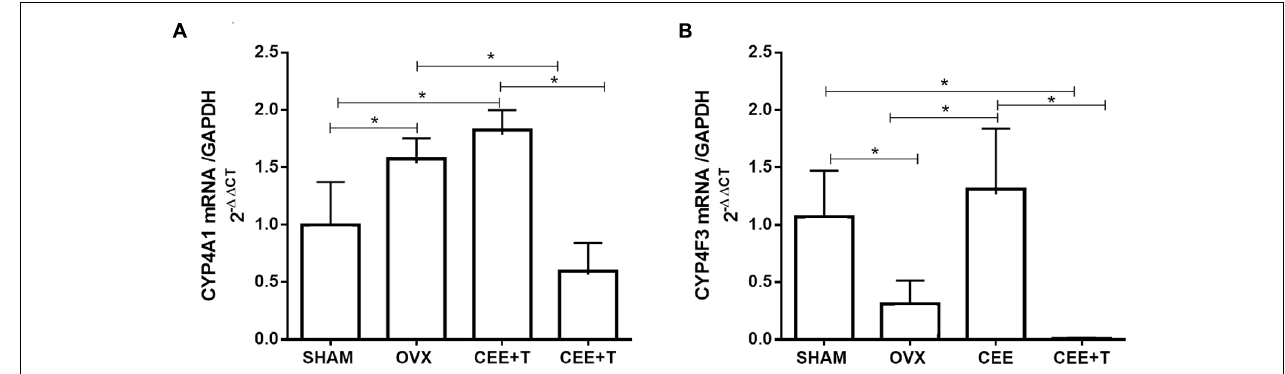
FIGURE 5 | mRNA levels of CYP4A1 (A) and CYP4F3 (B) normalized by GAPDH in aorta of SHAM, ovariectomized (OVX), OVX treated with conjugated equine estrogens (CEE) and OVX treated with CEE plus testosterone (CEE+T) female spontaneously hypertensive rats. Results represent the mean ± SEM from 3 to 6 independent experiments. One-way ANOVA: ∗ P < 0.05.